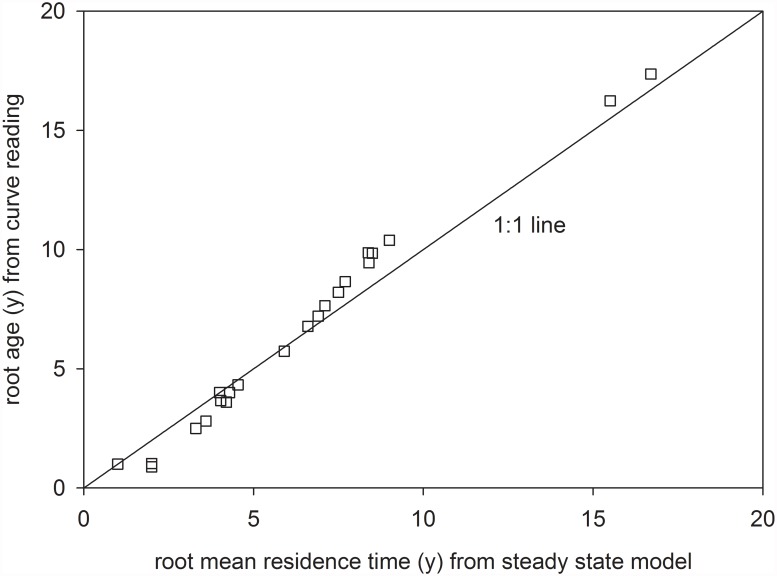
Comparison of root mean residence times estimated from steady-state turnover modeling (x axis) and root age as estimated from curve reading of the atmospheric radiocarbon bomb peak (y axis) for depth 0–10 cm.